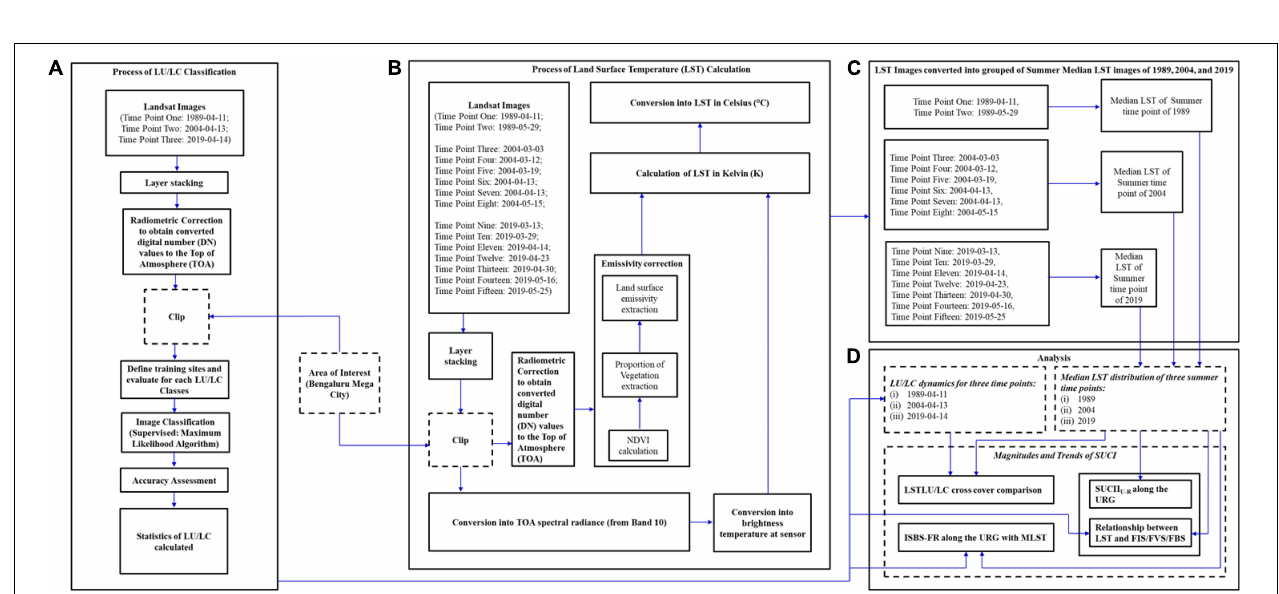
FIGURE 2 | Flowchart of (A) LU/LC classification; (B) LST calculation; (C) median LST calculation for each summer timepoints of selected years (i.e., 1989, 2004, and 2019); and (D) analysis of the study.